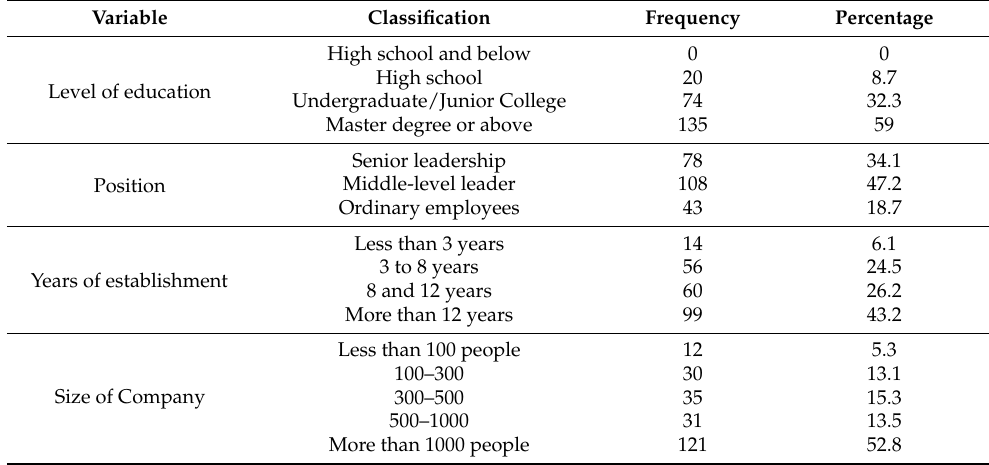
Table 1. Sample distribution